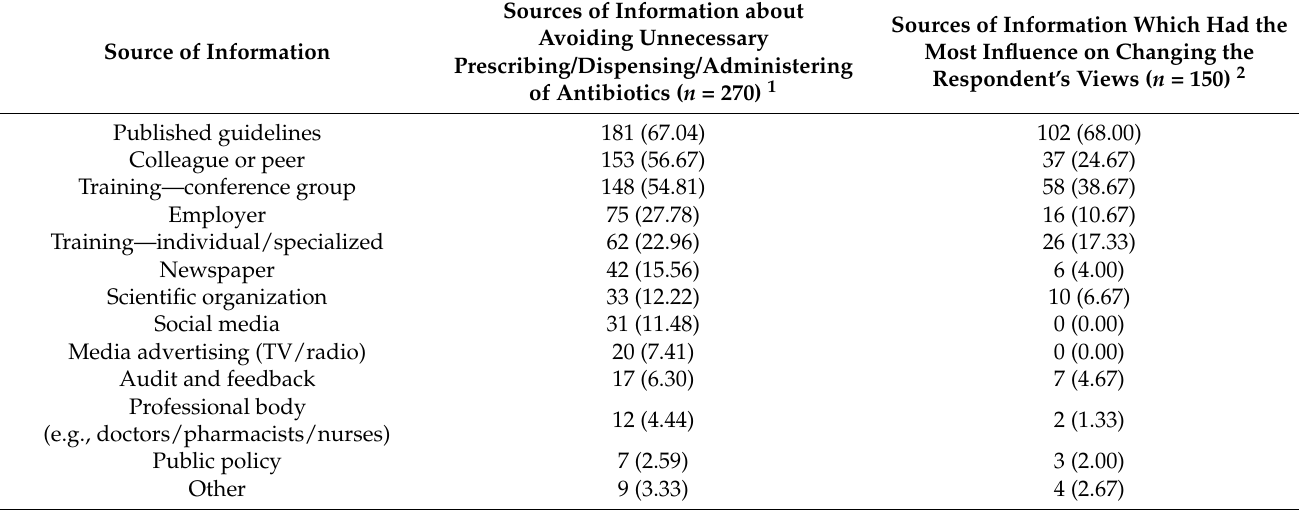
Table 3. Sources of information about avoiding unnecessary prescribing/dispensing/administering of antibiotics and sources of information with the most influence on changing the respondents’